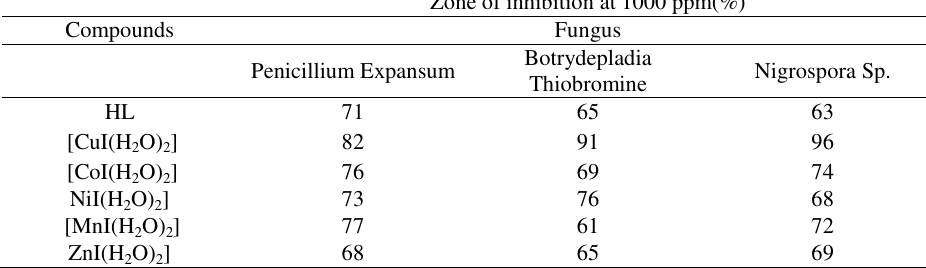
Table-2 : Antifungal activity of compounds Zone of inhibition at 1000 ppm(%) Compounds Fungus